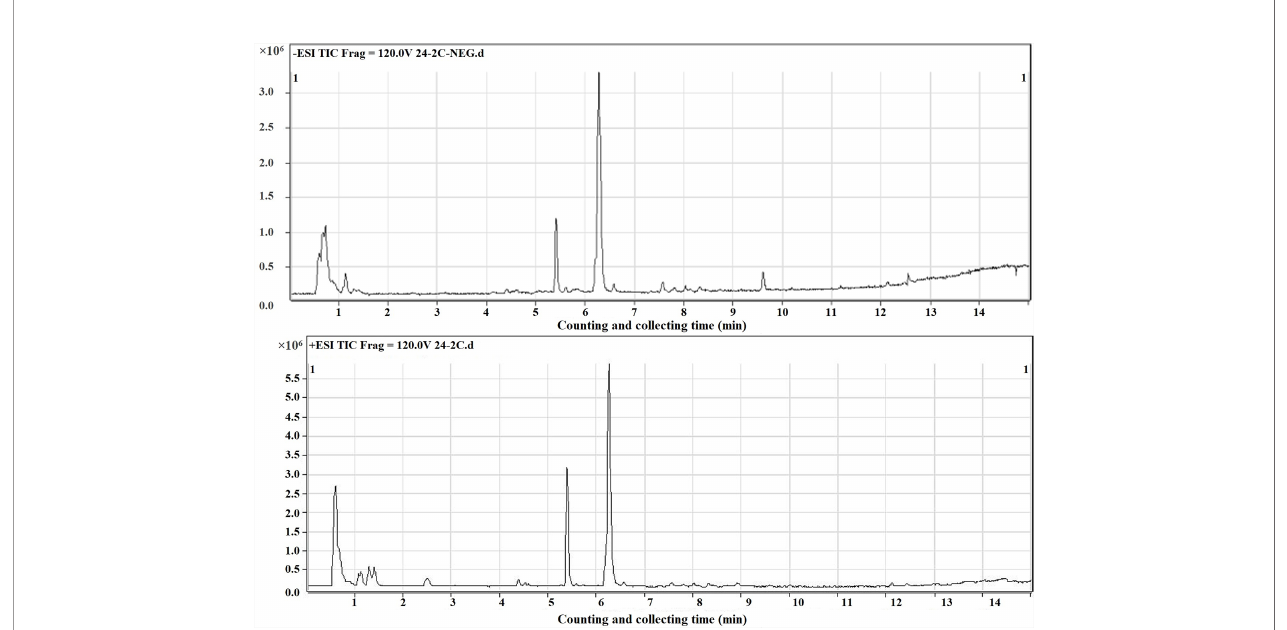
FIGURE 4 | Total ion current chromatogram of carbon ion 2 Gy irradiated